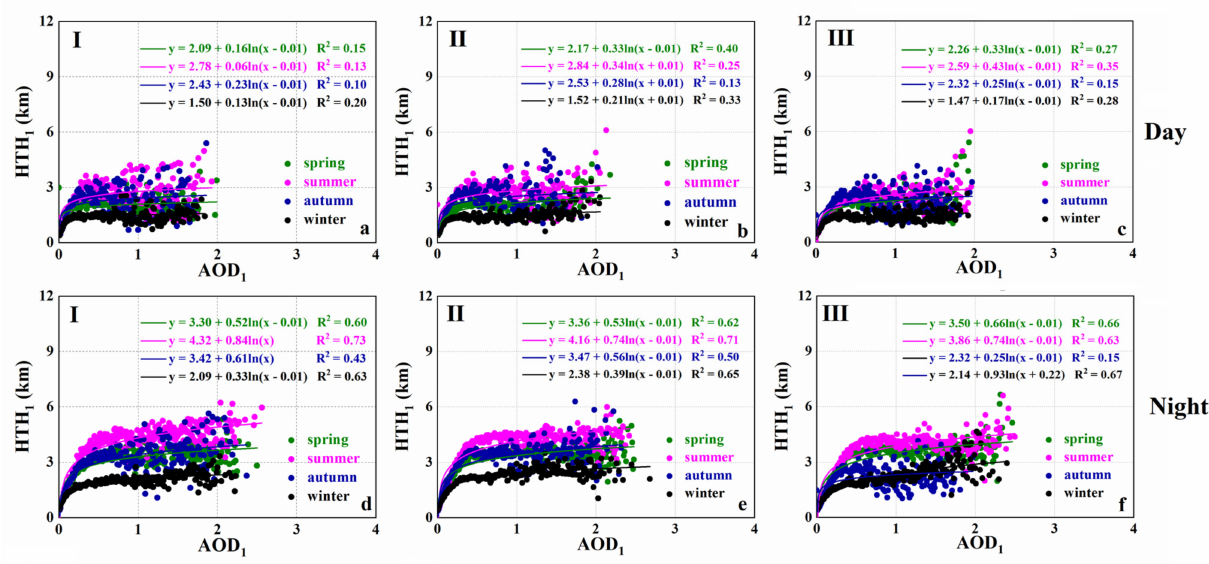
Figure 17. The correlation between HTH 1 and AOD 1 over Saudi Arabia from 2007 to 2019. ( a , d ) rep- resent region I, ( b , e ) represent region II, and ( c , f ) represent region